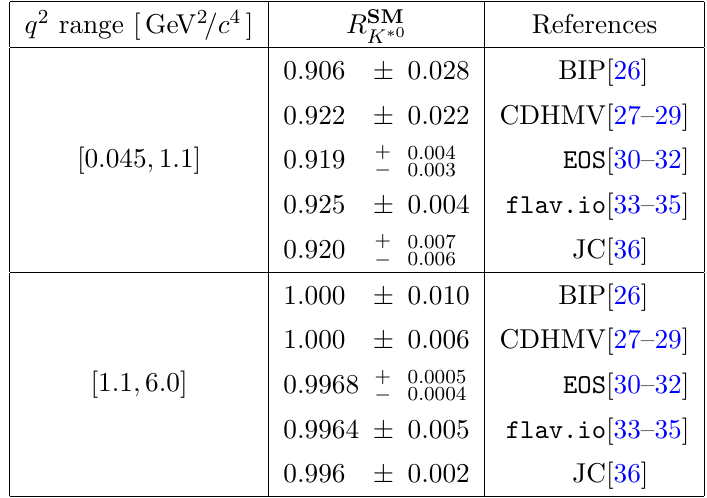
Table 1 . Recent SM predictions for R